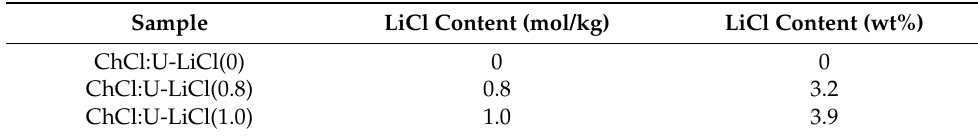
Table 1. Samples used in this